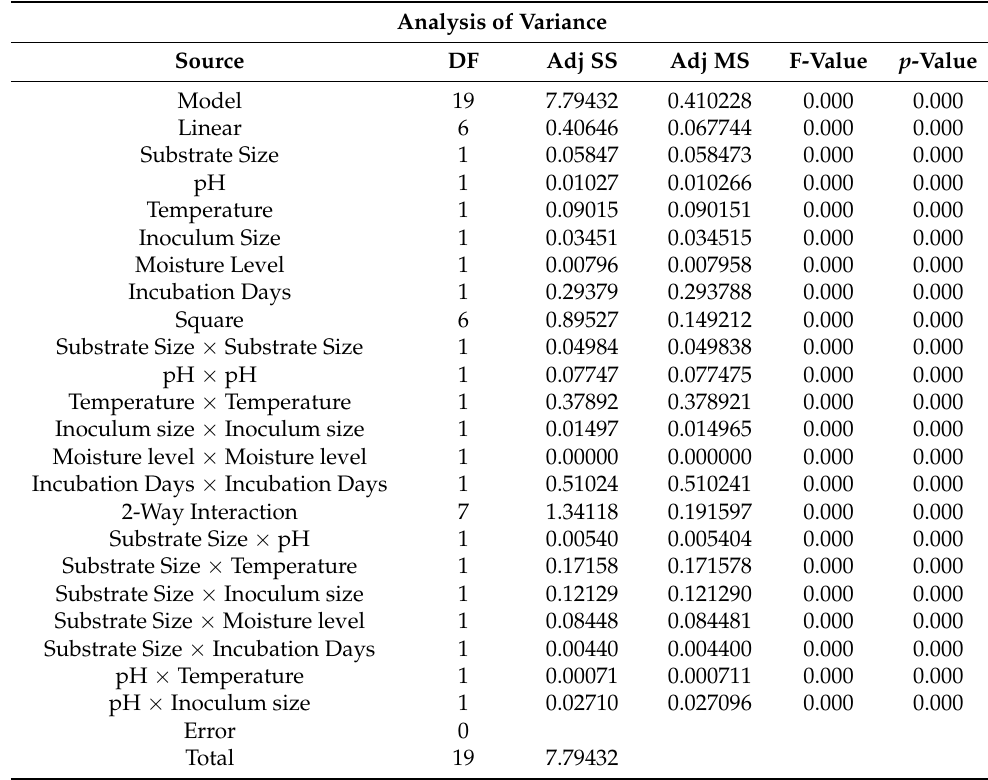
Table 4. Regression surface analysis: Enzyme Activity versus Substrate Size, pH, Temperature, Inoculum Size, Moisture Level, and Incubation